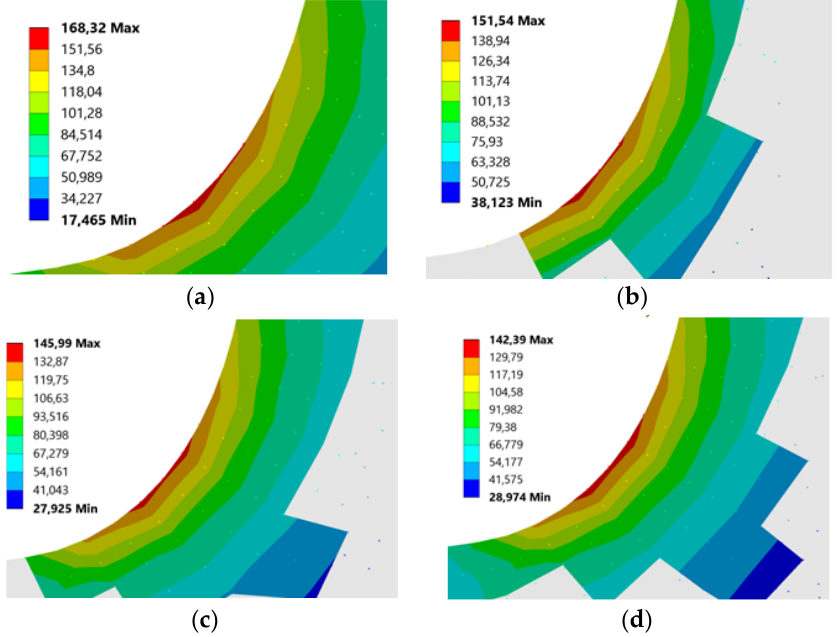
Figure 8. Root stress results for hybrid gears generated rack tip radius, ρ 1 = 0.2 xm for different RTs; ( a ) 0.5 xm, ( b ) 1 xm, ( c ) 1.5 xm, ( d ) 2